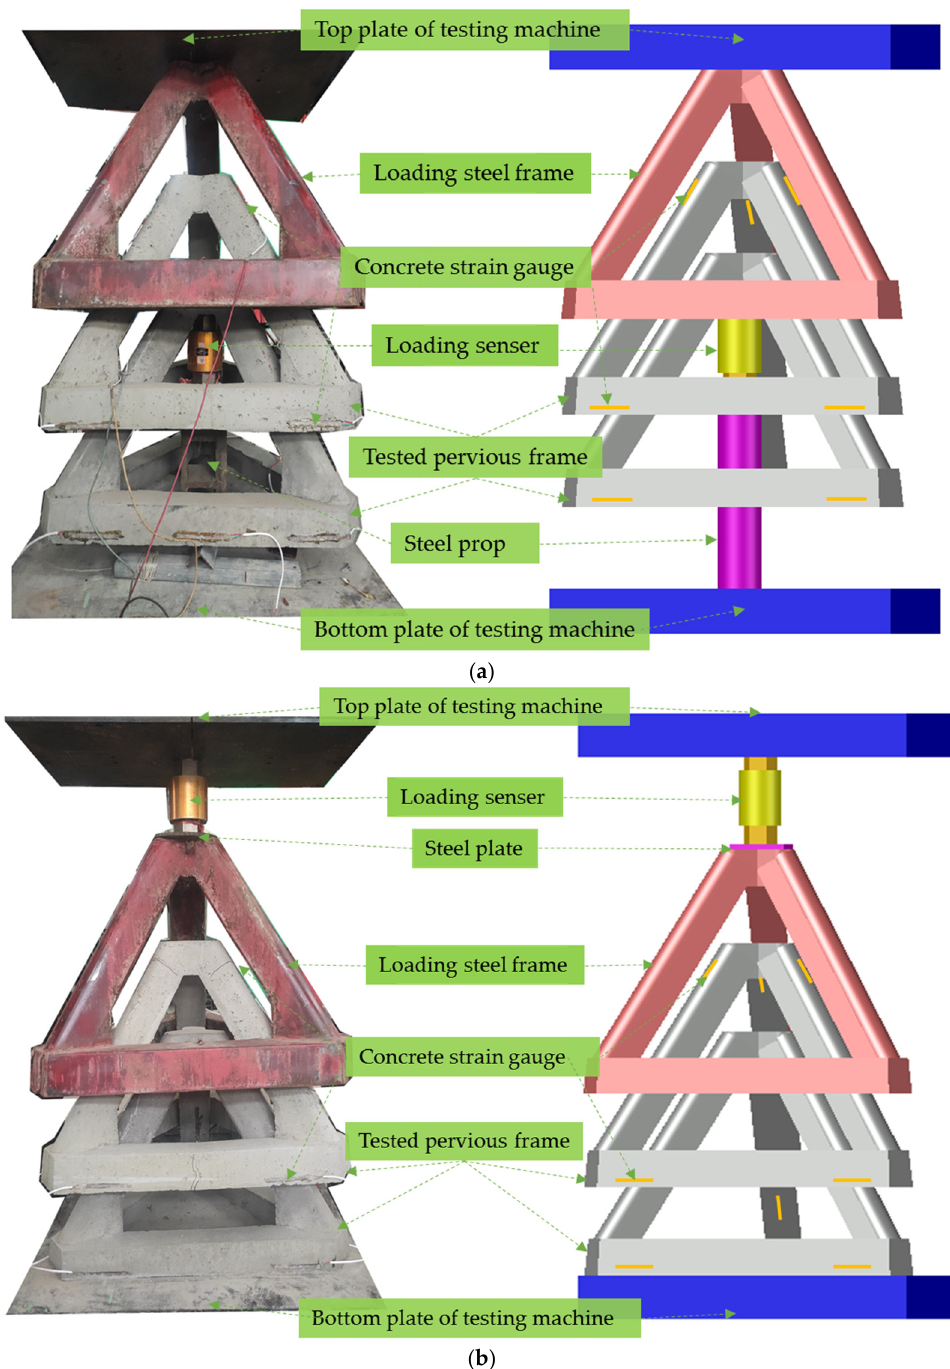
Figure 4. Test methods for pervious frames: ( a ) Lifting; ( b ) Stacking.